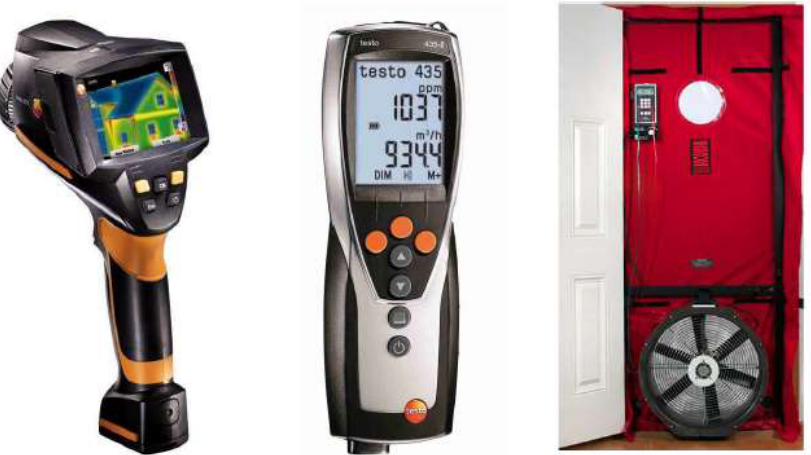
Figure 1. The thermal imaging camera, the transmittance meter, and the blower door test device.